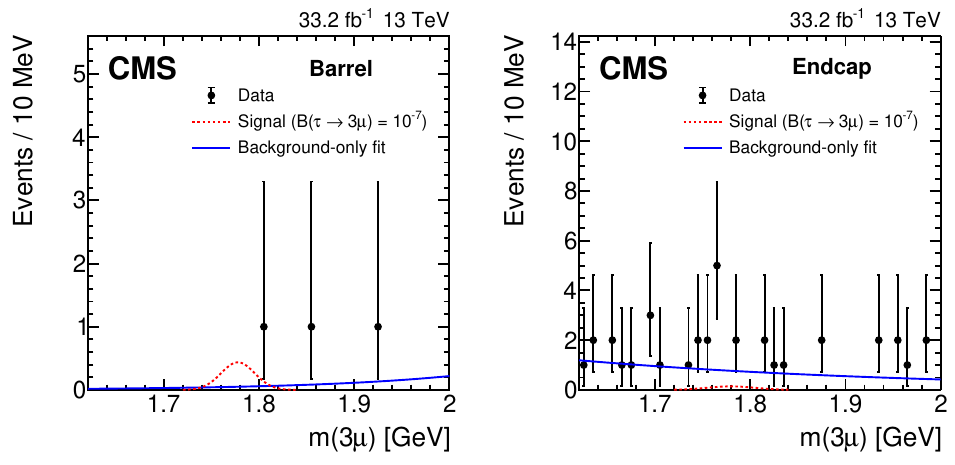
Figure 1 . Trimuon invariant mass distributions for barrel (left) and endcap (right) categories of the W boson analysis. The data are shown with filled circles and vertical bars representing the statistical uncertainty. The background-only fit and the expected signal for B ( t → 3 m ) = 10 − 7 are shown with solid and dashed lines,